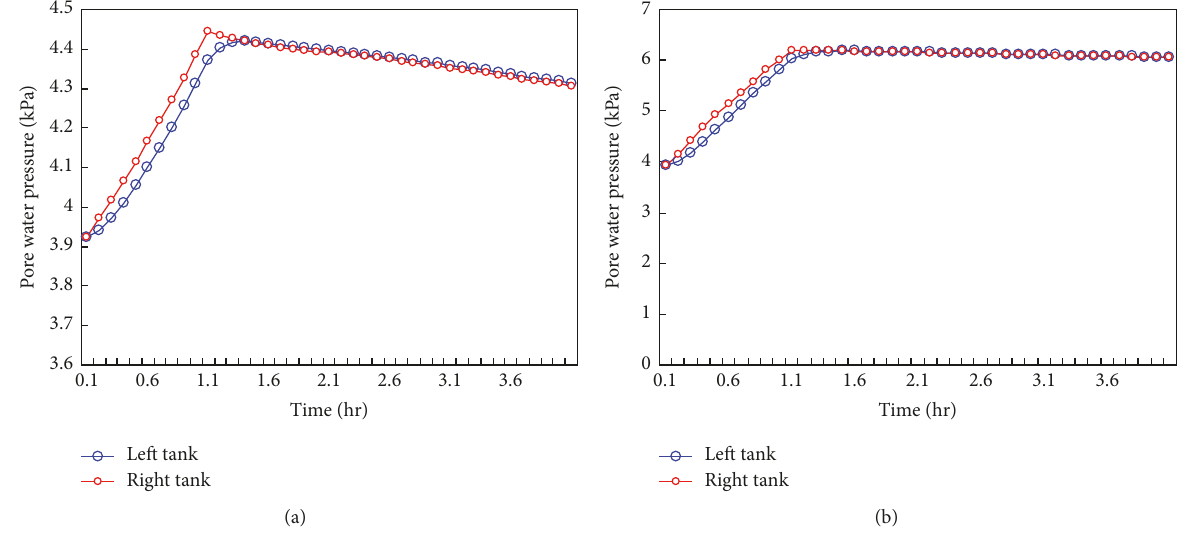
Figure 14: Monitoring data of numerical model (coarse materials): (a) 45 mm/hr rainfall intensity and (b) 65 mm/hr rainfall intensity.